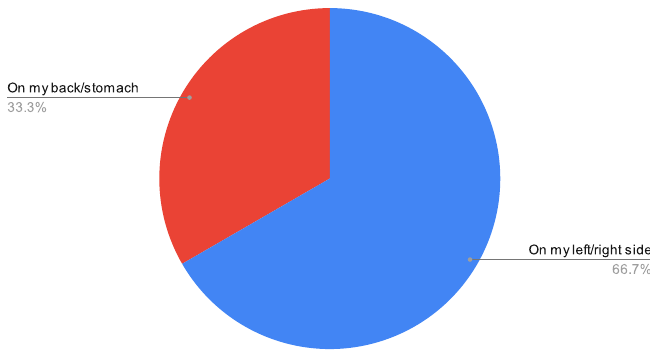
Figure 12. Position of Sleep After Experiment.